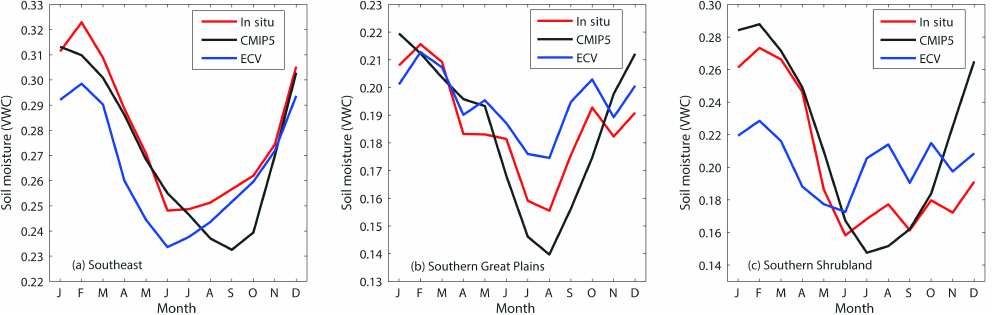
Figure 10. Seasonal variation of mean monthly (2003–2012) soil moisture based on in situ observations (red), CMIP5 ensemble (black) and ECV satellite data (blue) in three subregions: (a) Southeast, (b) Southern Great Plains and (c) Southern Shrubland.